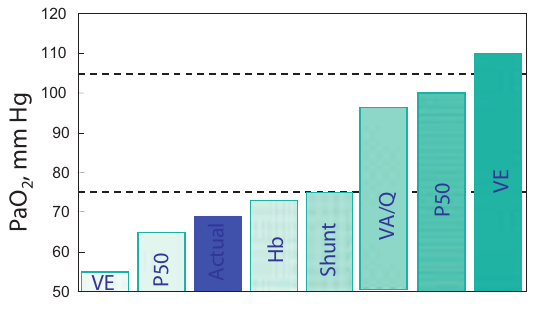
Measured and calculated arterial PO 2 (PaO 2 ) in 10 patients with liver cirrhosis. Columns show the mean actual value and the effects of normalisation procedures performed using the mathematical model of the multiple inert gas elim- ination technique. Thus, PaO 2 decreases after normalisation of circulating haemoglobin (Hb) and P 50 , increases after normalisation of shunt and ventilation/perfusion (VA/Q) imbalance, and increases even further after addition of measured increases in ventilation (VE) and P 50 . From